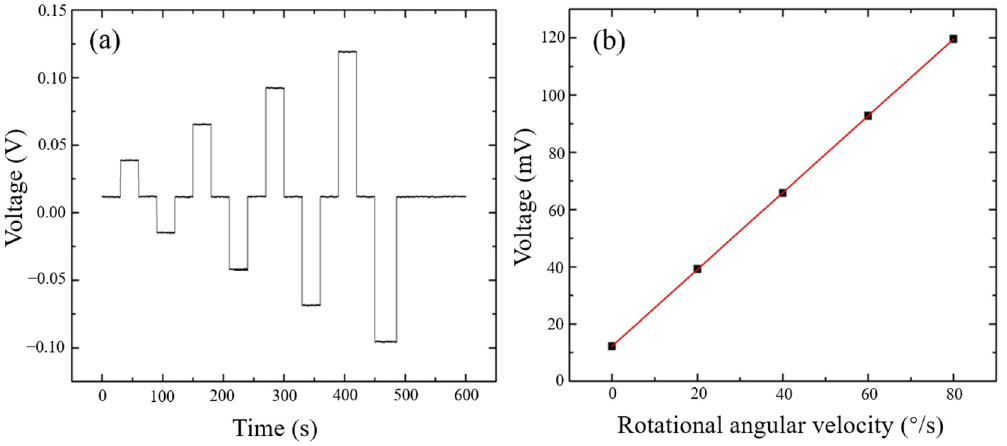
Figure 5. ( a ). Rotation step signals; ( b ) least square fitting ( g 1 = 6.9 µ m and g 2 = 6.7 µ m).